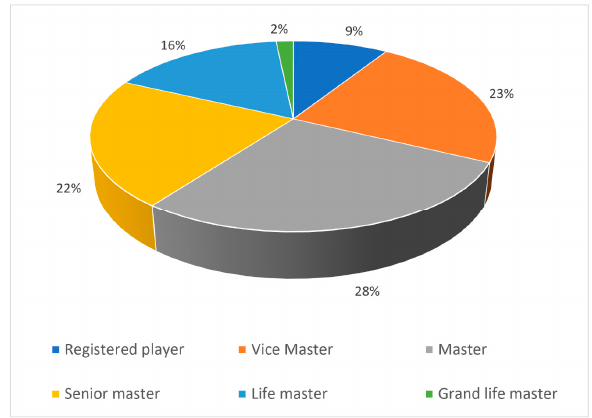
Figure 1. Player level categories.